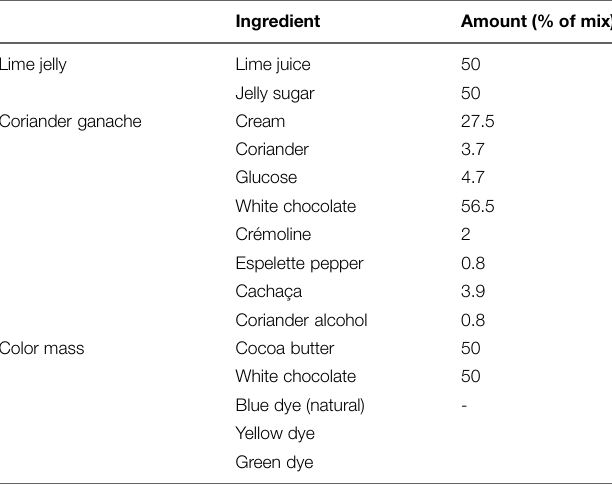
TABLE 1 | Description of chocolate praline ingredients, based on the original recipe.